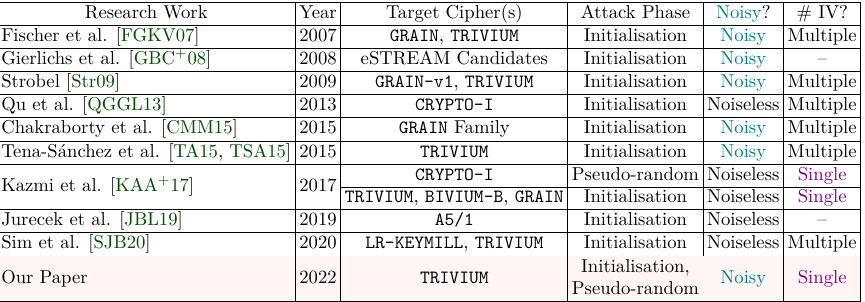
Table 1: A comparative study of our work with other stream cipher